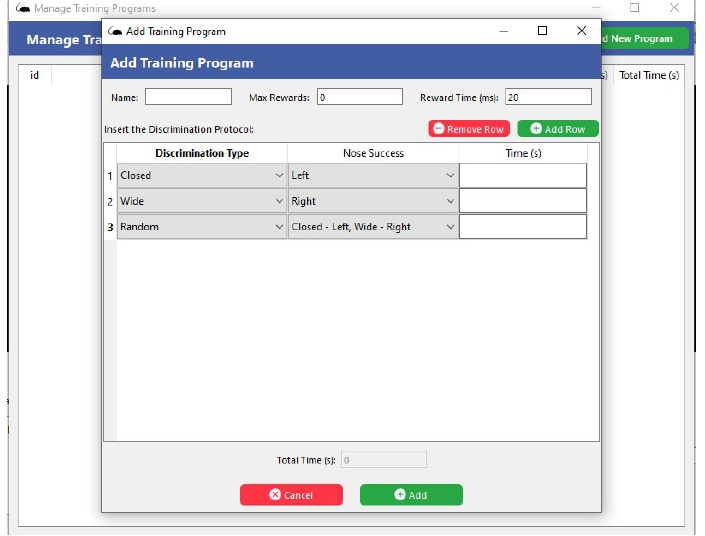
Figure 8. Screen of the Training Program function of the supervisory